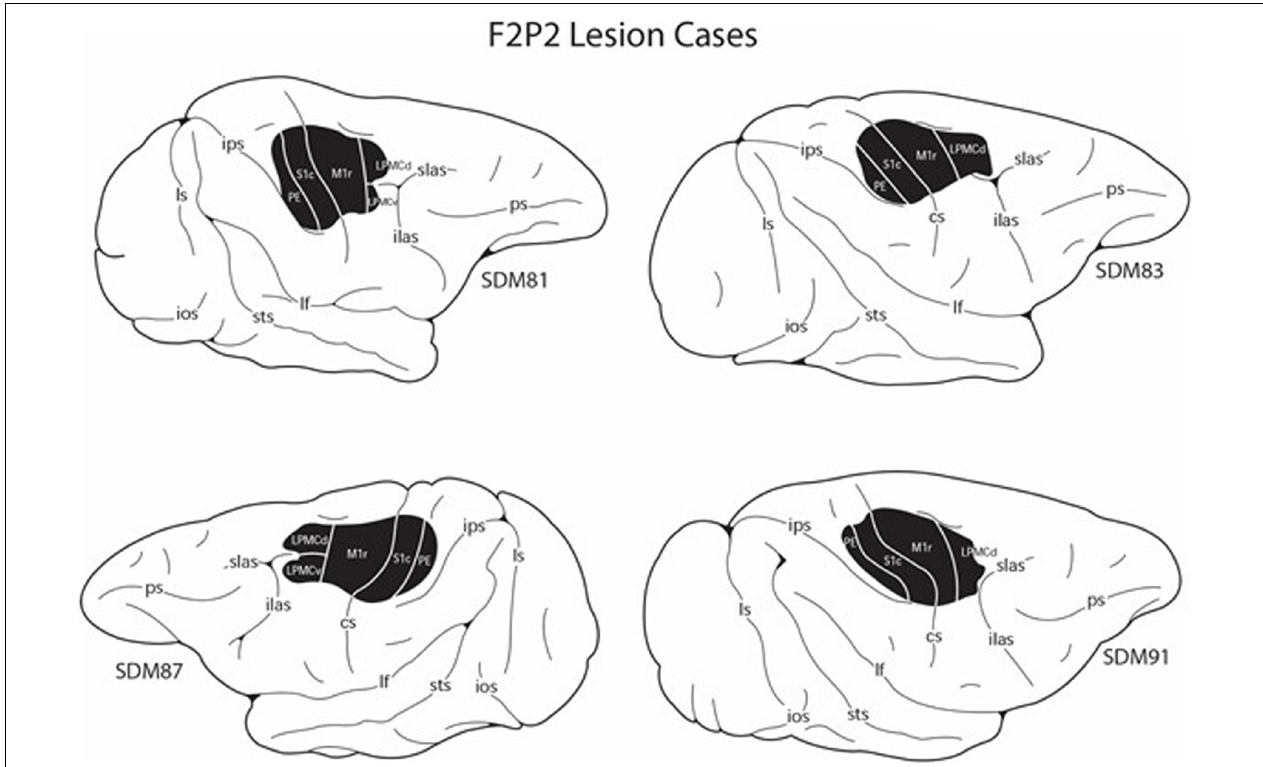
FIGURE 2 | Line drawings of the lateral surface of the cerebral cortex showing the M1 + LPMC + anterior parietal cortex lesion site locations (blackened area) in the four F2P2 lesion cases. Detailed descriptions of the histological and cytoarchitectonic characteristics of each lesion are provided in previous reports along with microstimulation maps of the cortical surface that were used to guide the placement of each lesion (Morecraft et al., 2015; Darling et al., 2016). cs, central sulcus; ecs, ectocalcarine sulcus; ilas, inferior limb of the arcuate sulcus; ios, inferior occipital sulcus; ips, intraparietal sulcus; lf, lateral fissure; ls, lunate sulcus; ots, occipito-temporal sulcus; ps, principal sulcus; slas, superior limb of the arcuate sulcus; sts, superior temporal